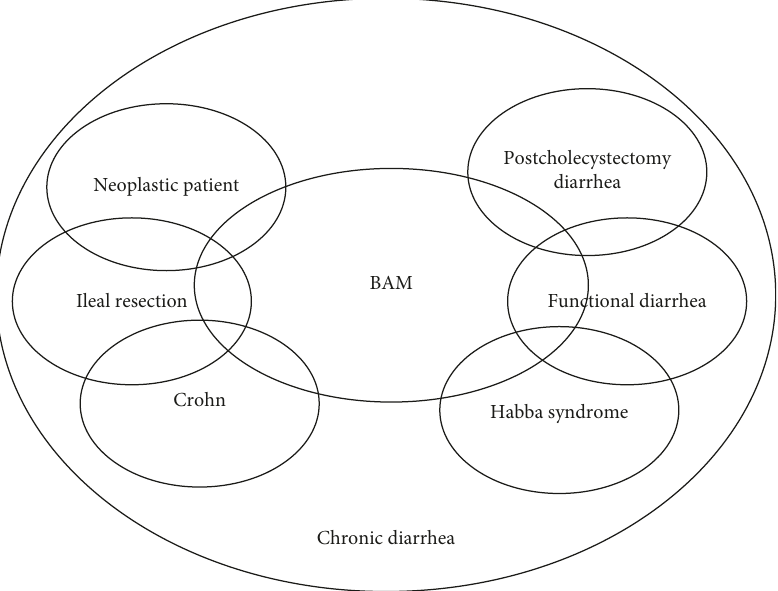
Figure 1: Venn diagram of di ff erent causes of chronic diarrhea related to